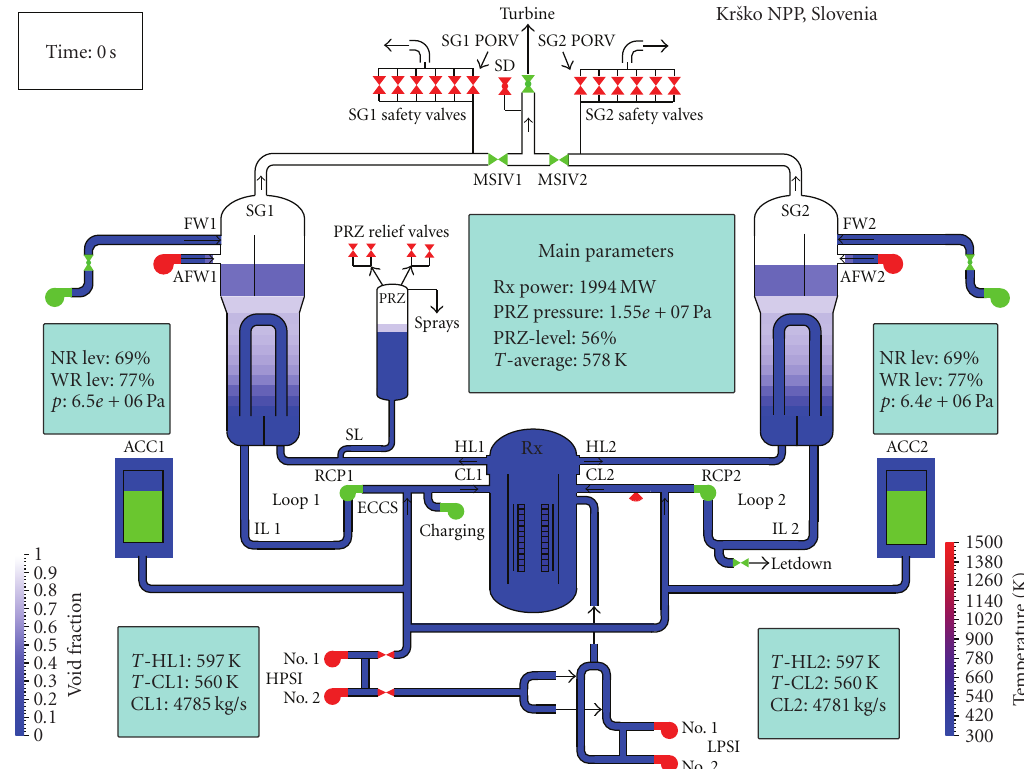
Figure 1: Krˇsko NPP animation mask at 0